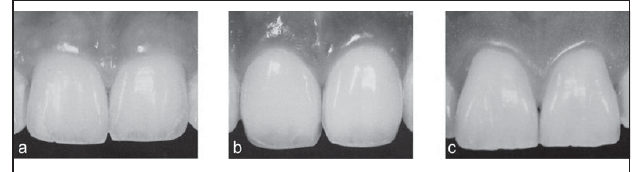
Fig. 3. Dental morphology according to the classification by Kina & Bruguera (2008): a) square tooth; b) ovoid tooth; and c) triangular tooth.